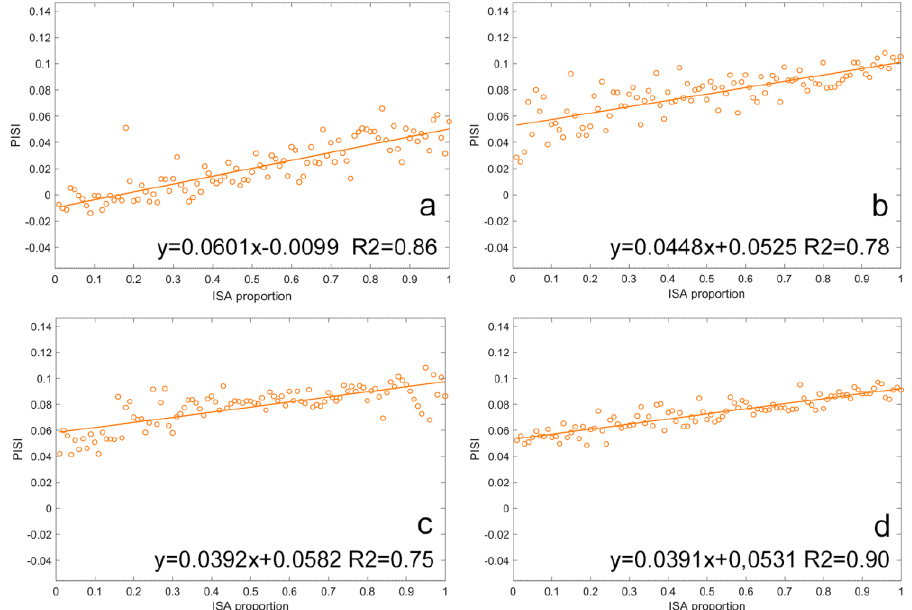
Figure 11. Relationship between PISI value and proportion of ISA in Landsat 8 images. ( a – d ) correspond to the subregions shown in Figure 7.